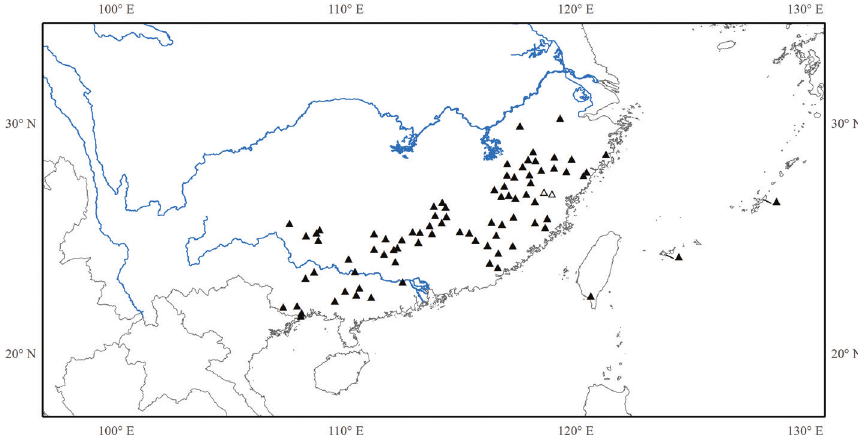
Figure 9. Distribution of Tashiroea . Hollow triangles indicate the locations of Tashiroea villosa . Species included in Tashiroea